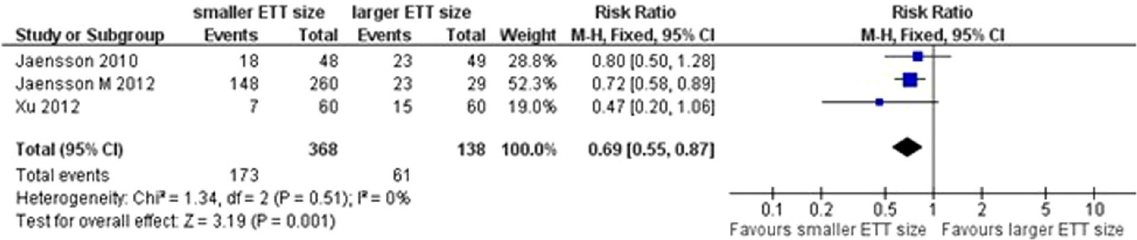
Figure 5. Forest plot of POST at 24 h after surgery.